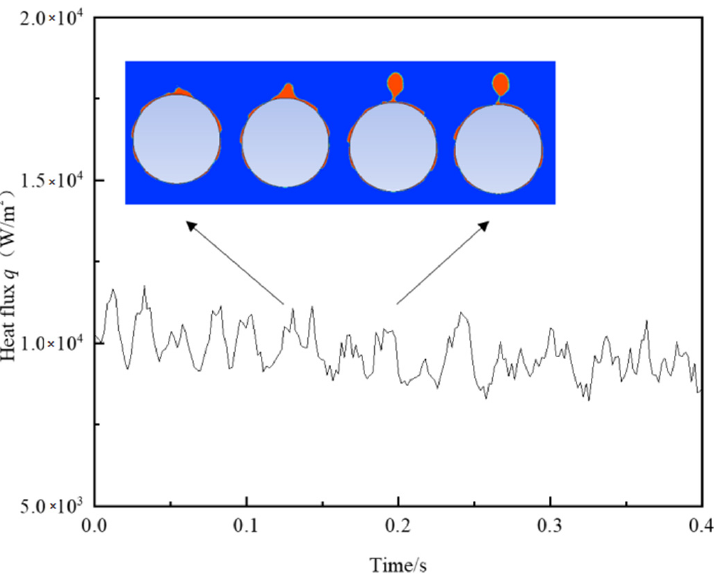
Figure 12. The spatial-averaged heat flux and the evolution of the gas–liquid interface for the 25 mm tube.